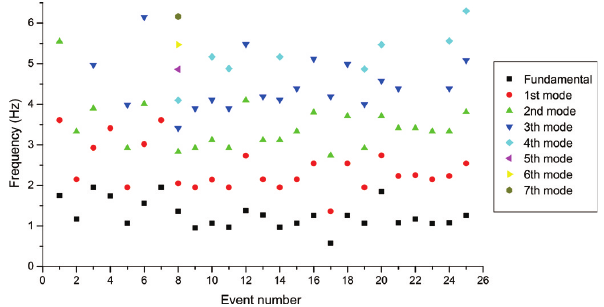
Fig. 3. Diagram showing the number of different frequency over- tones for each volcanic tremor event under